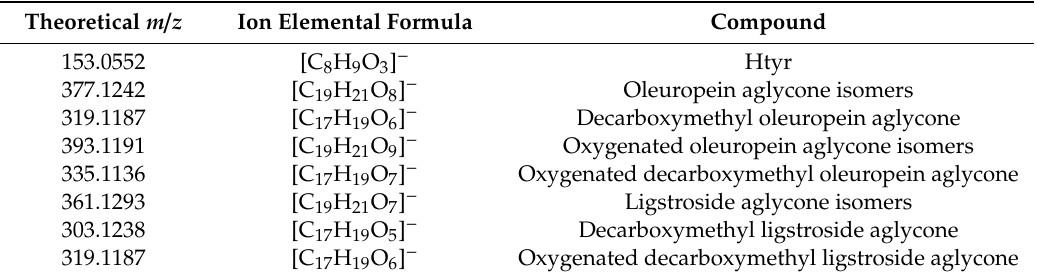
Table 7. Htyr and Tyr derivatives evaluated in negative ionization mode setting the mass range to m / z